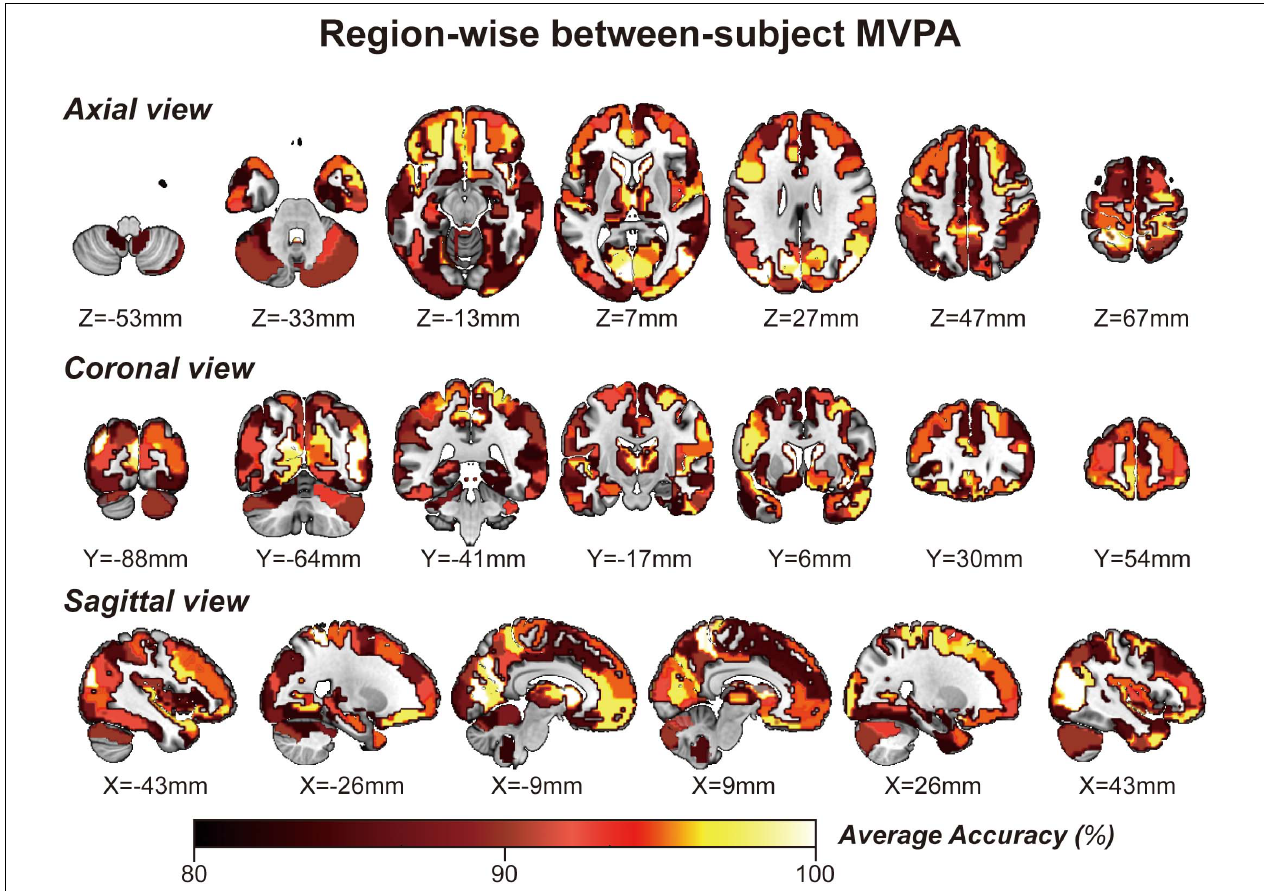
FIGURE 4 | Whole-brain regionwise within-subject MVPA result obtained from “navigational vs. non-navigational” state classification. The hot bar at the bottom indicates percentage accuracy values. Numbers represent X (sagittal view), Y (coronal view), and Z (axial view) coordinates in the MNI space.